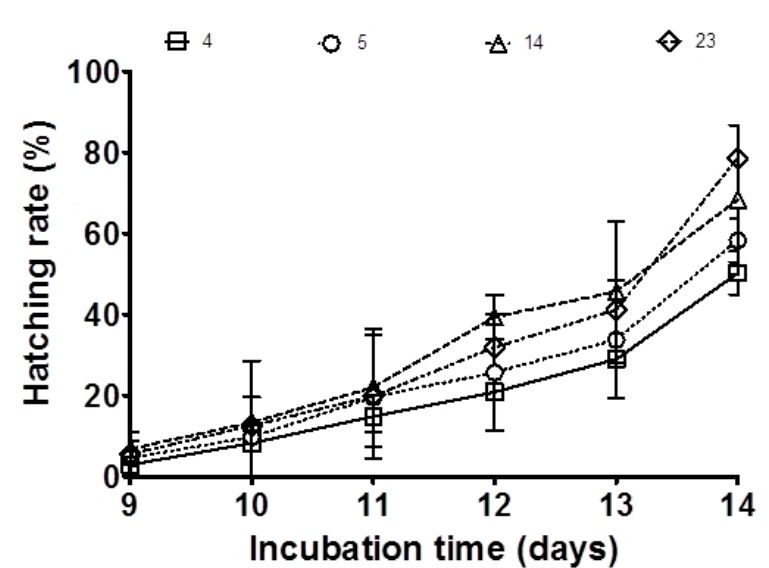
Figure 3. Effect of ARA on the hatching rate derived from medaka broodstock fed diets with different amounts of ARA (4, 5, 14, 23 mg g − 1 TFA) for three weeks. The values are means ± standard deviation (SD); each dietary treatment was carried out in triplicate (n = 3).